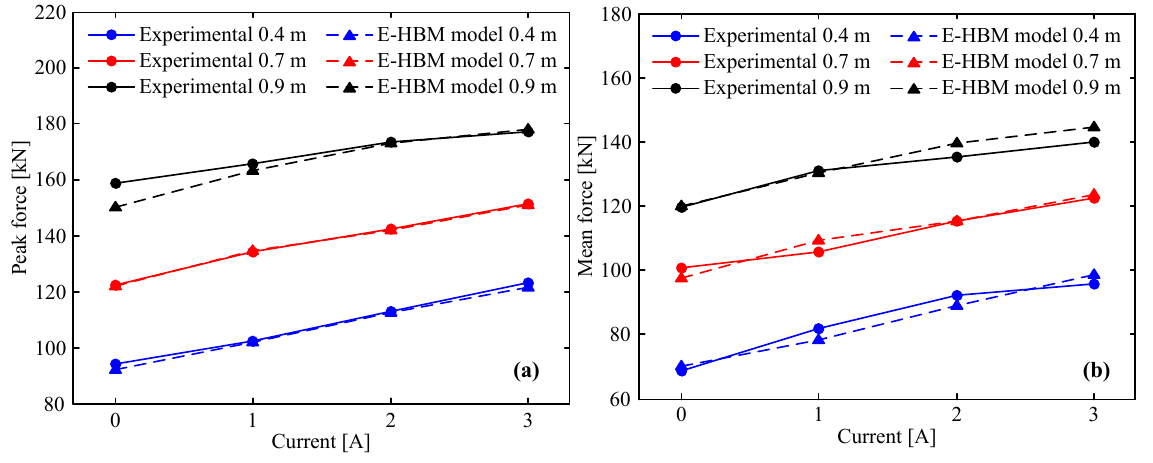
Figure 9. E–HBM model vs. measured data: ( a ) peak force, ( b ) mean force.